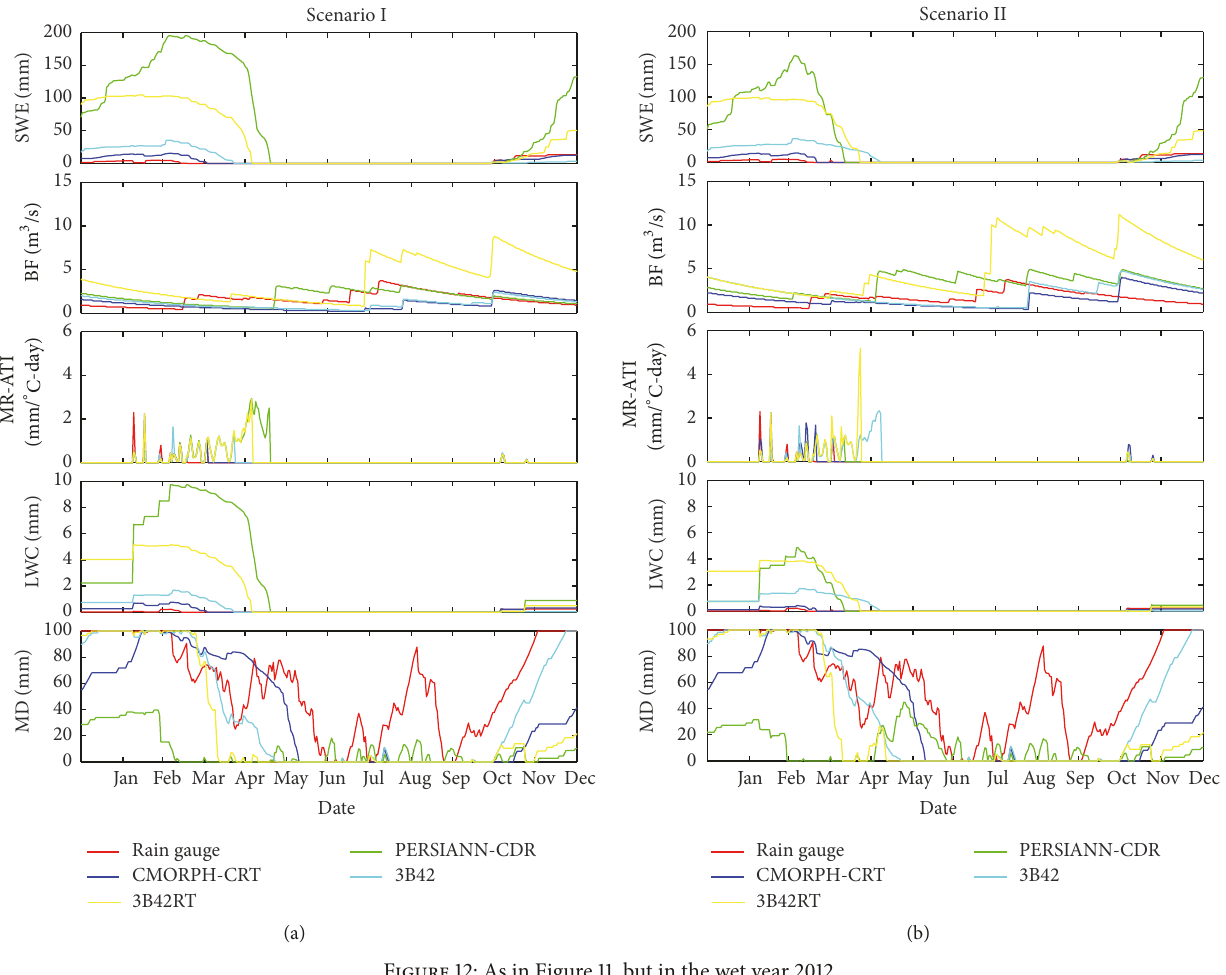
Figure 12: As in Figure 11, but in the wet year